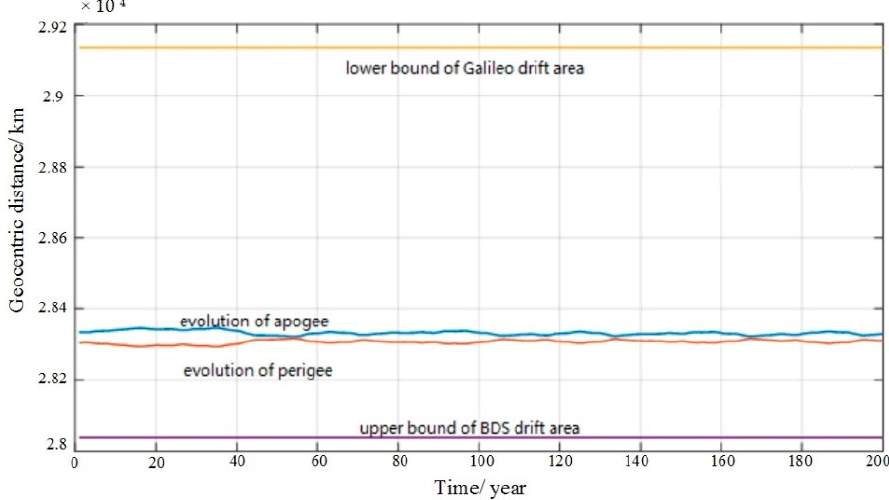
Figure 19. Variations in the minimum perigee and the maximum apogee of the optimal disposal orbit. As shown in Figure 17, the semimajor axis of the optimal disposal orbit varies from 28,319.583 km to 28,319.604 km over 200 years. From Figure 18, the eccentricity of the optimal disposal orbit varies from 0.000002 to 0.001029 over 200 years. From Figure 19, the perigee of the optimal disposal orbit varies from 28,290.446 km to 28,319.537 km over 200 years, and the apogee of the optimal disposal orbit varies from 28,319.646 km to 28,348.729 km over 200 years. The closest range relative to the upper bound of the BDS satellite drift area is 253.446 km, and the closest range relative to the lower bound of the Galileo satellite drift area is 786.271